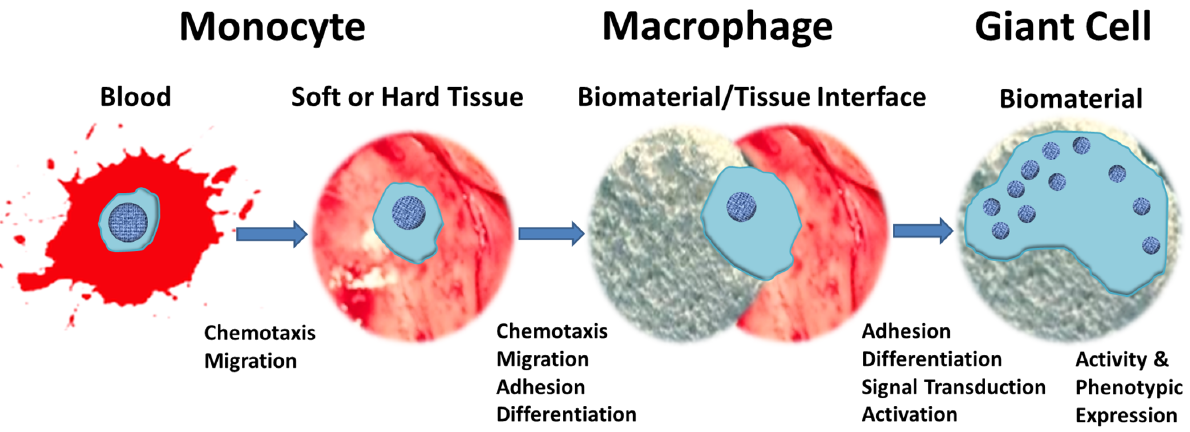
Figure 2. A schematic depiction of the transition of a blood-circulating monocyte to biomaterial/tissue interface-adherent monocyte/macrophage to foreign body giant